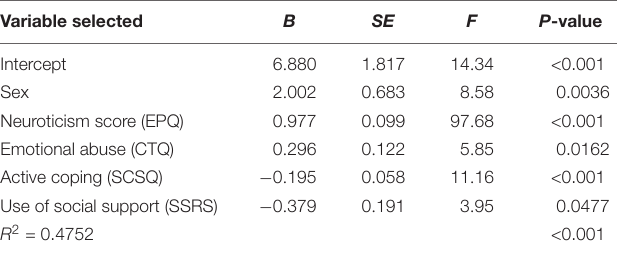
TABLE 2 | The results of stepwise multiple regression analysis of PHQ-9.